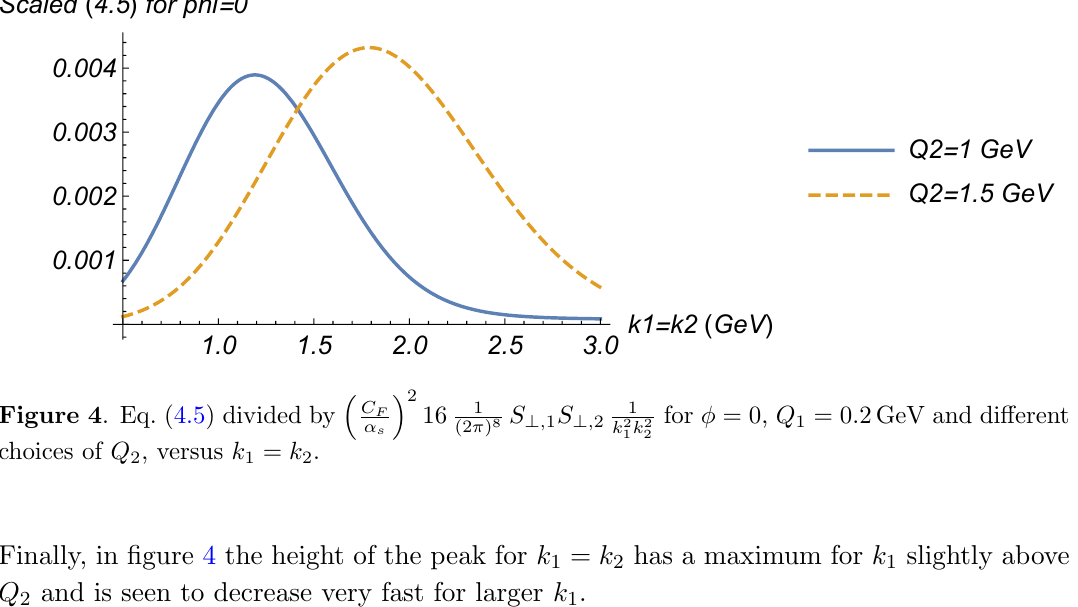
(cid:16) (cid:17) 2 C F 16 1 S ? ; 1 S ? ; 2 1 for (cid:30) = 0, Q 1 = 0 : 2 GeV and di(cid:11)erent (cid:11) s k 2 1 k 2 2 (2 (cid:25) ) 8